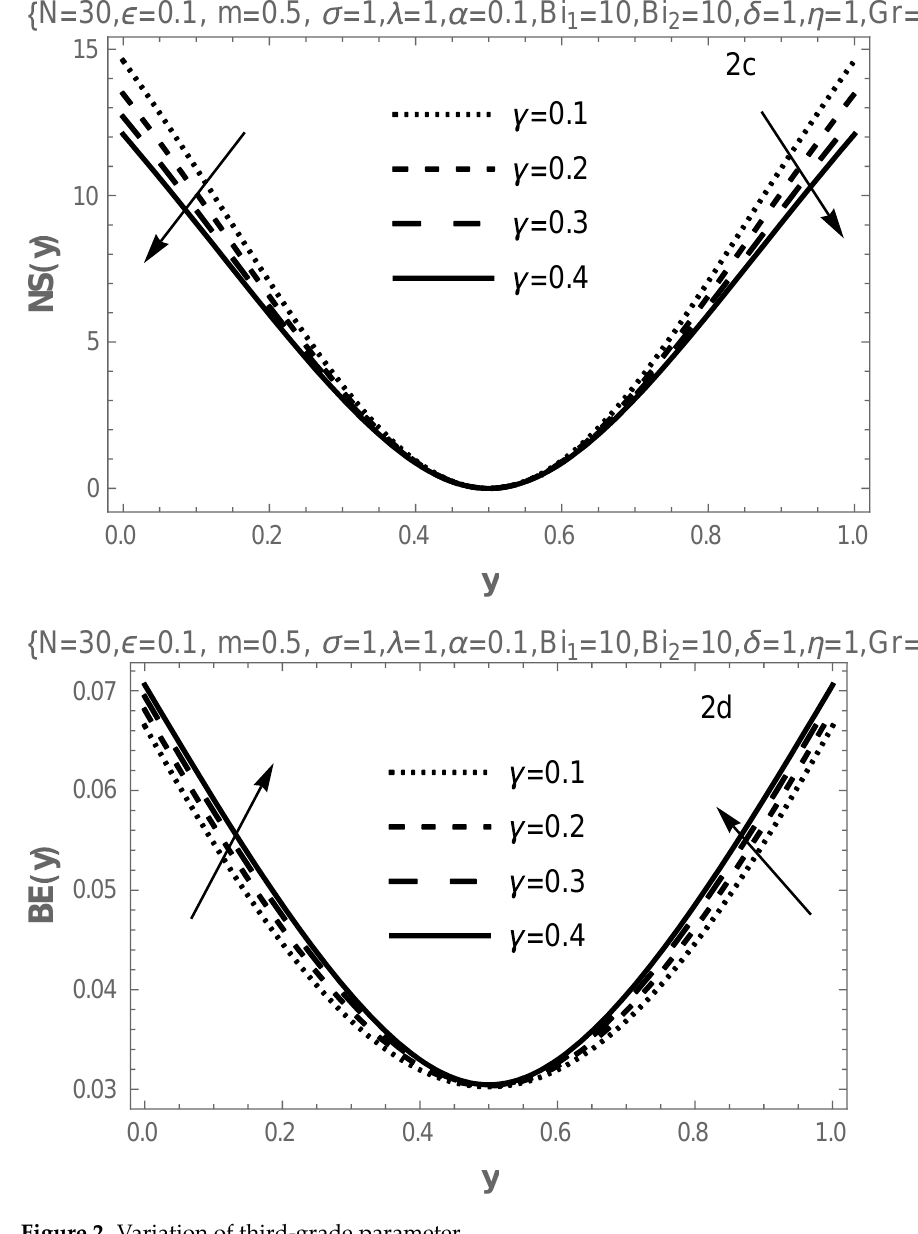
Figure 2. Variation of third‑grade parameter. Figure -2. Variation of third-grade parameter. Figure 3a–d represent the impact of buoyancy forces on the flow field on the